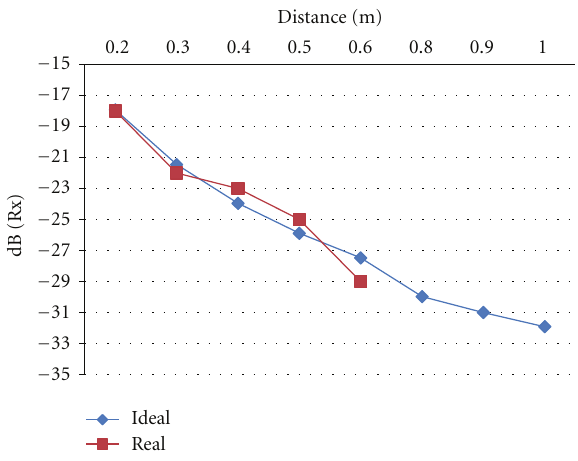
Figure 12: Transmitter power consumption test result.